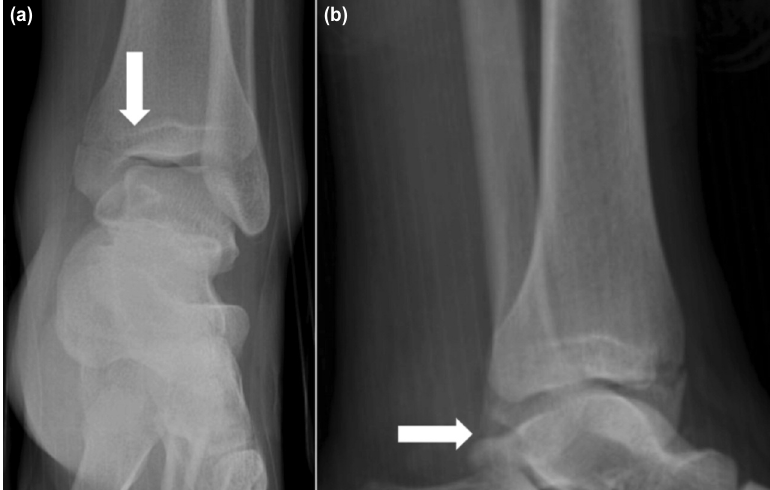
(a) Anteroposterior and (b) Lateral ankle radiographs of the patient on admission showed minimally-displaced fracture of Fig. 1: medial malleolus and a suspicious avulsion fracture on posterior part of lateral malleolus.